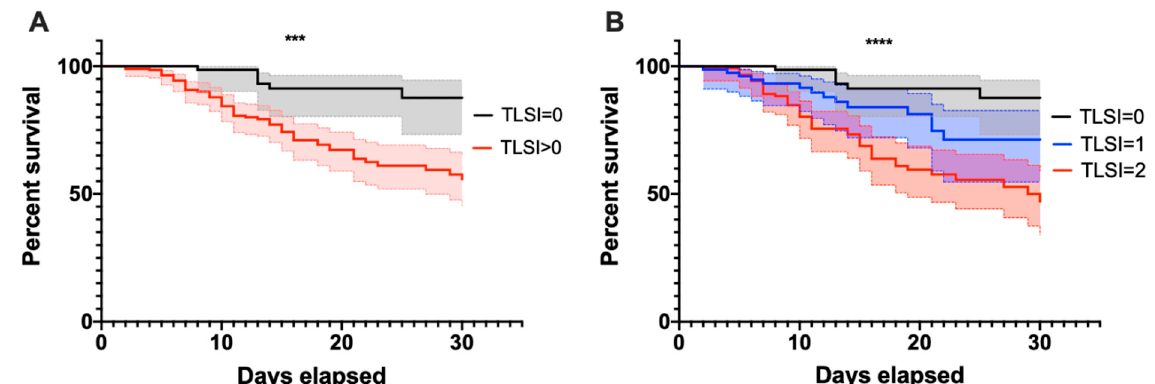
Figure 2. Thirty-day survival curves of COVID-19 patients according to TLSI score. Survival curves at 30 days after the onset of symptoms in hospitalized COVID-19 patients, stratified into two ( A ) and three ( B ) groups, according to TLSI score, ranging from 0 to 2. The analysis was performed with the Log-rank (Mantel-Cox) test. The log-rank test for trend was also used for the survival analysis of the cohort after stratification into three groups ( B ), showing a statistically significant trend from TLSI = 0 to TLSI = 2, p < 0.0001. Dashed lines delimit the 95% interval confidence area, which was filled in with the corresponding color. TLSI: T-Lymphocyte subset index; ***: 0.001 < p < 0.0001; ****: p < 0.0001.